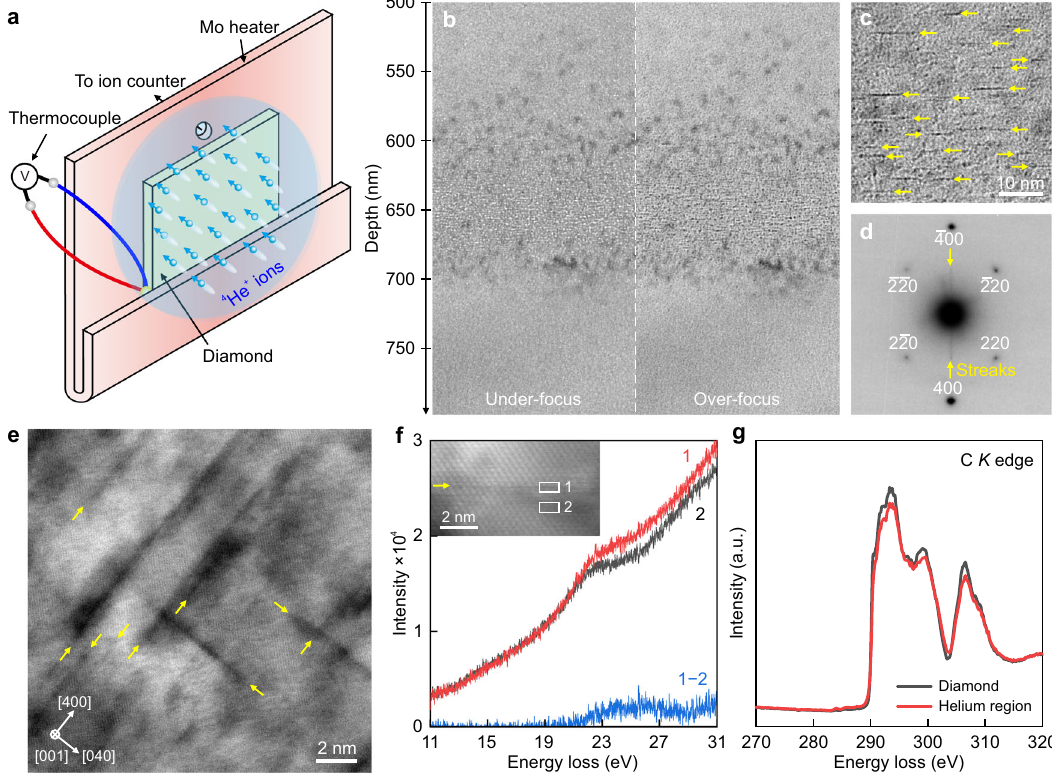
d Selected area electron diffraction pattern of the helium region con fi rms the formation of {100} helium platelets. e HAADF STEM image illustrates {100} helium platelets. f Low-loss electron energy-loss spectraobtained on (area 1) and off (area 2) the platelet. g Core-loss electron energy-loss spectra show carbon K edge from the helium ion implantation region and the pristine diamond. Source data are provided as a Source Data fi